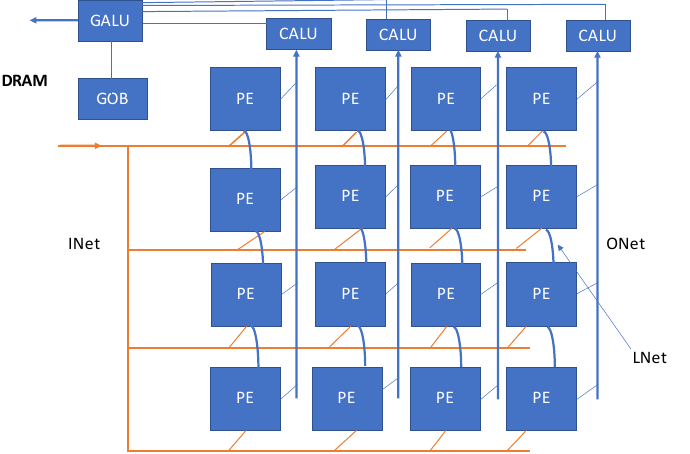
Figure 16. Atomic-layer architecture for ReRAM-based DNN accelerator design. PE: processing element; GOB: global output buffer [21].